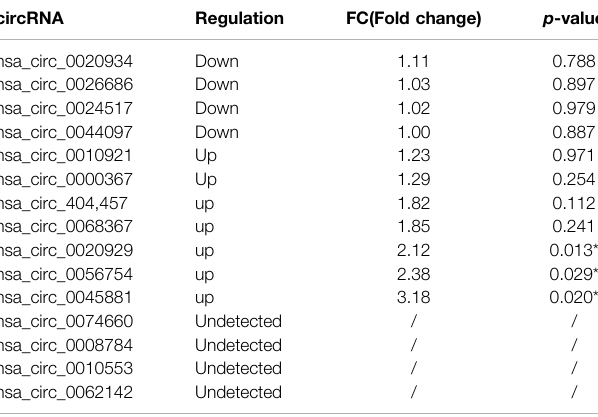
TABLE 3 | Differential expression of top 15 down-regulated circRNAs in imatinib- resistant cell lines K562/G01 vs imatinib sensitive cell lines K562